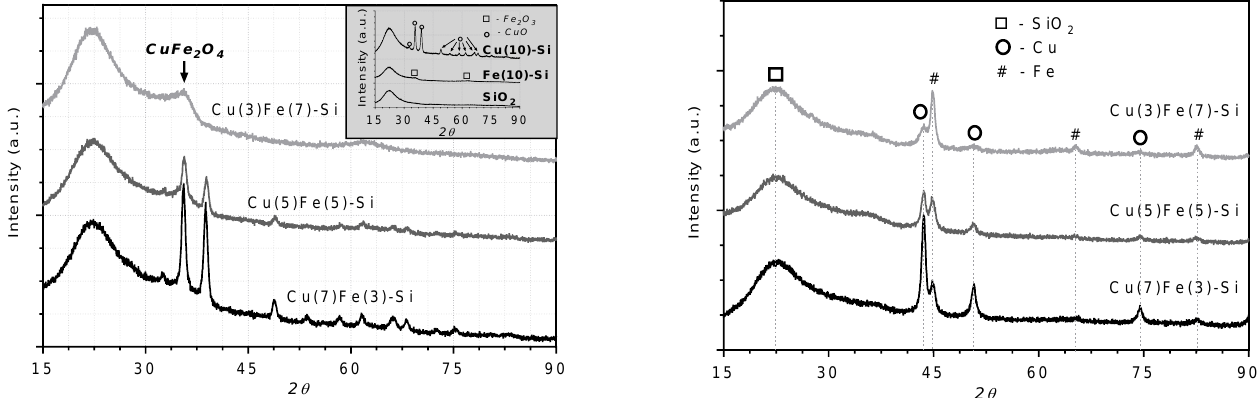
Figure 3. XRD patterns of the Cu(x)Fe(y)-Si catalysts after calcination ( left ) and reduction ( right ). Irrespective of the catalyst state (whether calcined or reduced), a broad band cantered at around 22.5° and attributable to amorphous silica is evident for all the samples. In the calcined samples (Figure 3 — left), the typical diffraction peaks of CuO well crystallized in the form of tenorite at 35.5 and 38.7° (JCPDS 05-0661) are well visible in the Cu(7)Fe(3)-Si sample, while as the iron loading increases, these reflections tend to decrease in intensity, till the appearance of a mixed oxide form in the Cu(3)Fe(7)-Si sample attributable to the cubic structure of a cuprospinel (CuFe 2 O 4 , JCPDS 25-0283). In any case, only low-intensity reflections ascribable to the cubic structure of maghemite (Fe 2 O 3 , JCPDS 39-1346) are de- tected on all the samples, consistent with the fact that Fe ions and Fe nanodomains are evidently embedded into the amorphous background of the SiO 2 phase. After reduction (Figure 3 — right), the Cu(x)Fe(y)-Si samples exhibit the formation of the respective metal- lic phases of copper at 43° (JCPDS 04-0836) and iron at 45° (JCPDS 06-0696), whose relative intensities are proportional to the metal loading on the micro-spherical silica. In order to determine the redox properties of the catalysts, Figure 4 shows the profiles of the temperature programmed measurements performed under hydrogen atmosphere (H 2 -TPR), while the quantitative results are reported in Table 2.